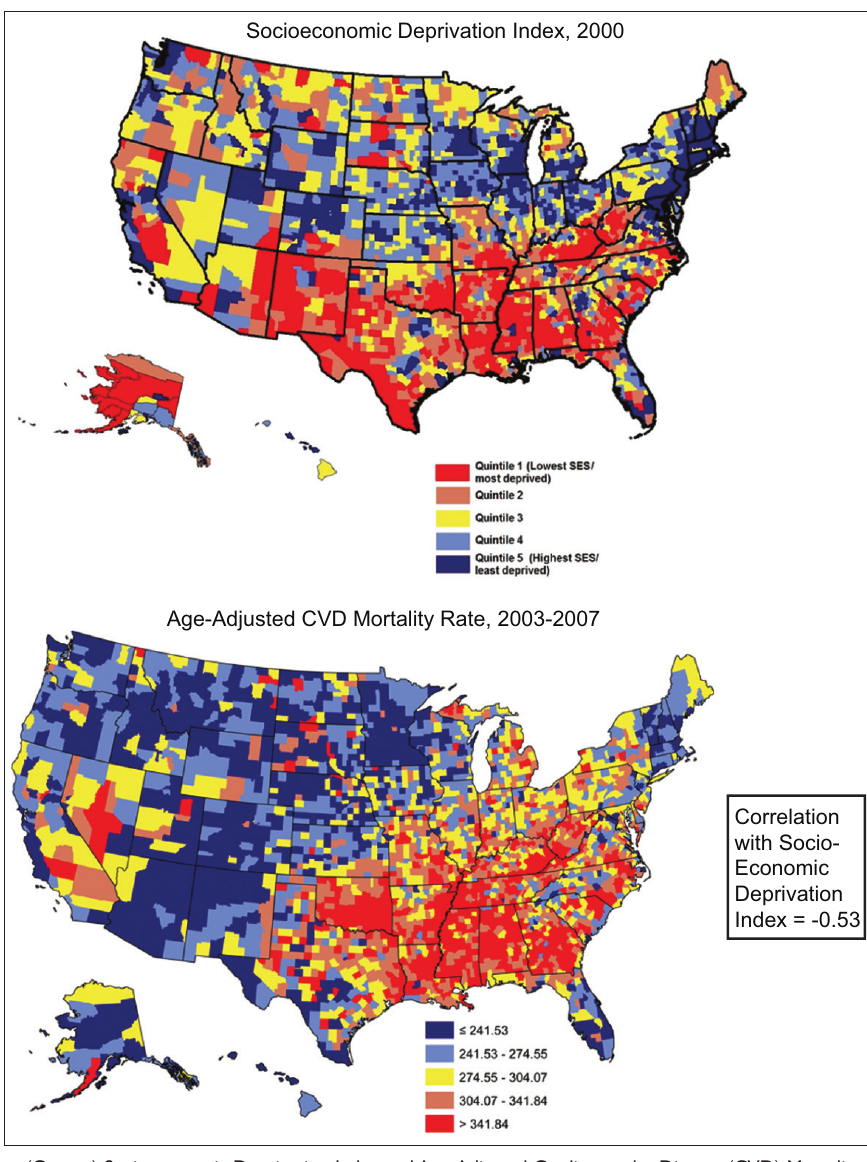
Figure 2 . Area (County) Socioeconomic Deprivation Index and Age-Adjusted Cardiovascular Disease (CVD) Mortality Rates per 100,000 Population for the United States (2000 US Population Used as Standard; 3,141 Counties) with a 32.2-point increase in the CVD mortality